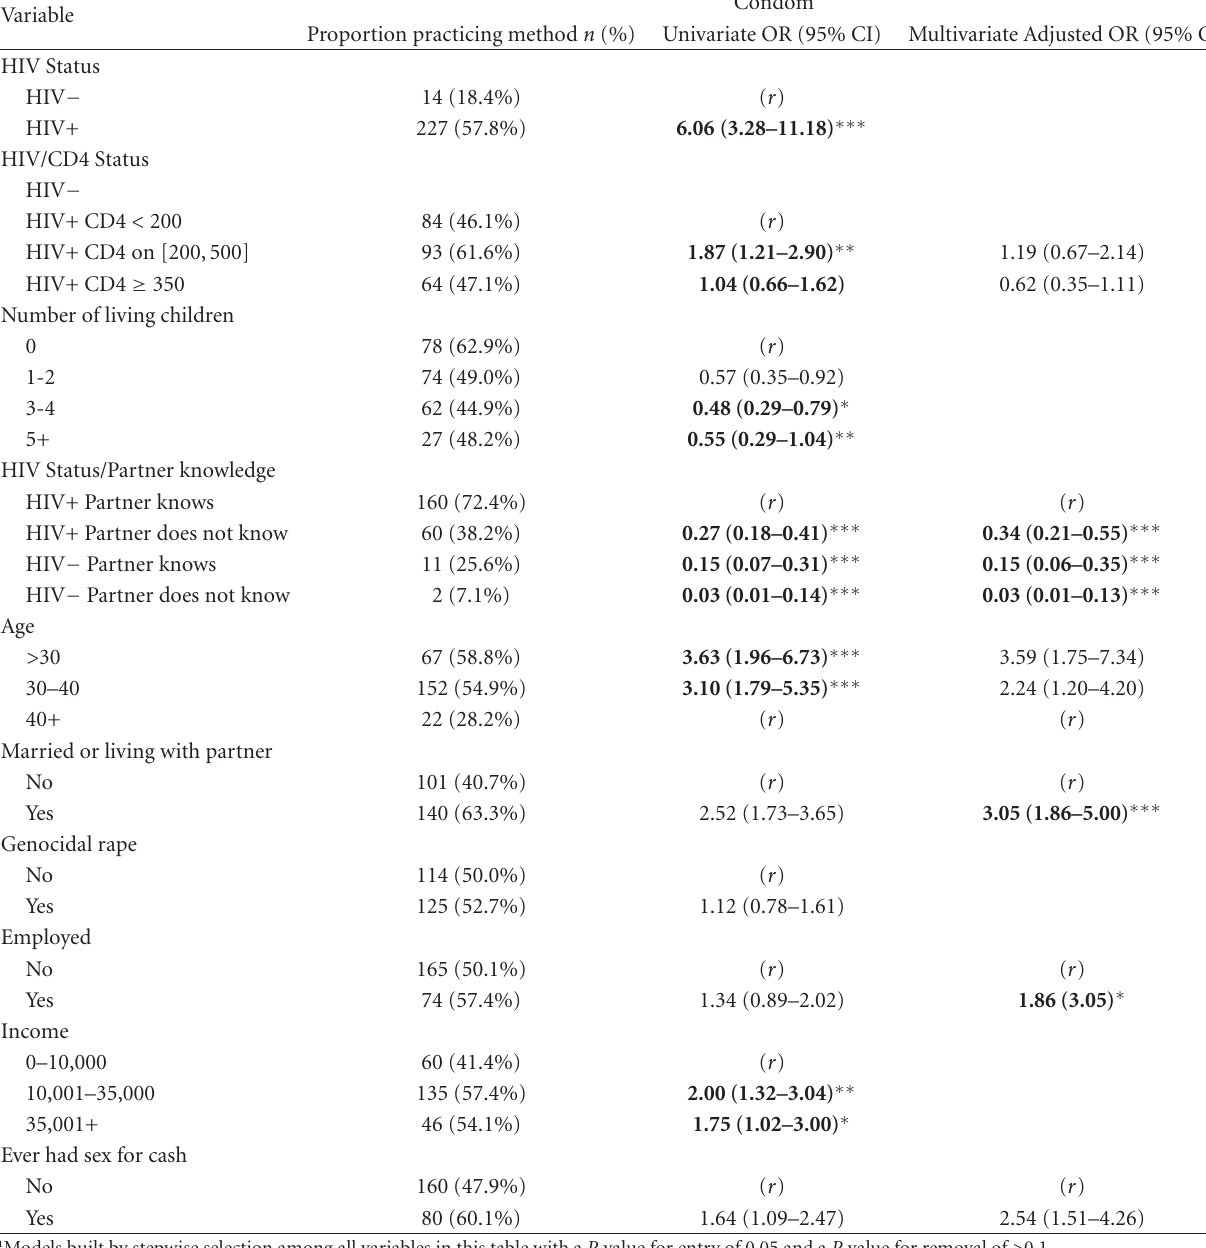
Table 3: Univariate and multivariate analysis of demographic and clinical characteristics associated with condom